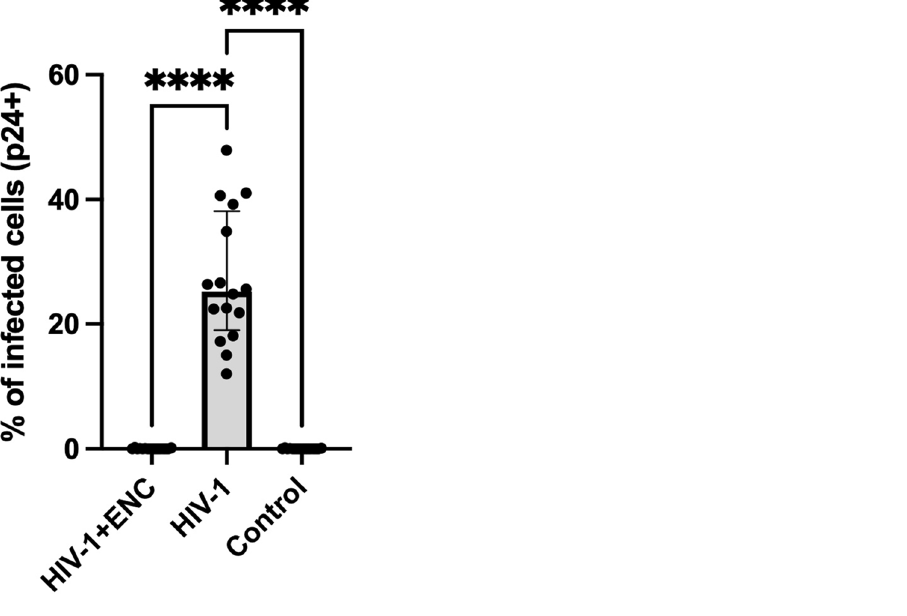
Figure 6. ENC prevented HIV-1 infection of MT-4 cells. MT-4 cells were inoculated with HIV-1 LAI.04 in conditions with and without endospermic nanocellulose (ENC) for four hours, thoroughly washed and cultured for four days. Cells were harvested for flow cytometry analysis and infection measured by intracellular p24 staining. No infection of cells was observed in cells when virus was entrapped in ENC (n = 16, **** p < 0.0001 compared to positive control cells, Kruskal–Wallis test, median with interquartile range). The level of intracellular p24 in HIV-1 + ENC conditions was not different from negative control cells with no